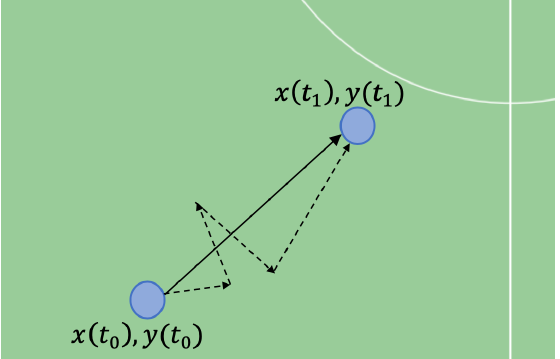
Figure 1. Approximation of player movement speed and direction. Solid lines represent constructed approximation; dashed lines correspond to the original player